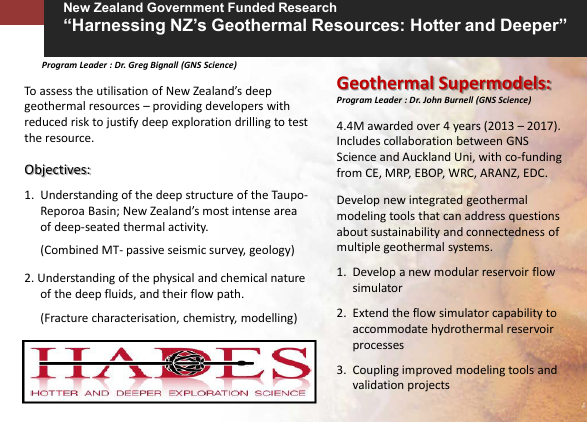
Figure 6. The aims of Project HADES in New Zealand. Figure courtesy of Ted Bertrand (GNS-Science, New Zealand).